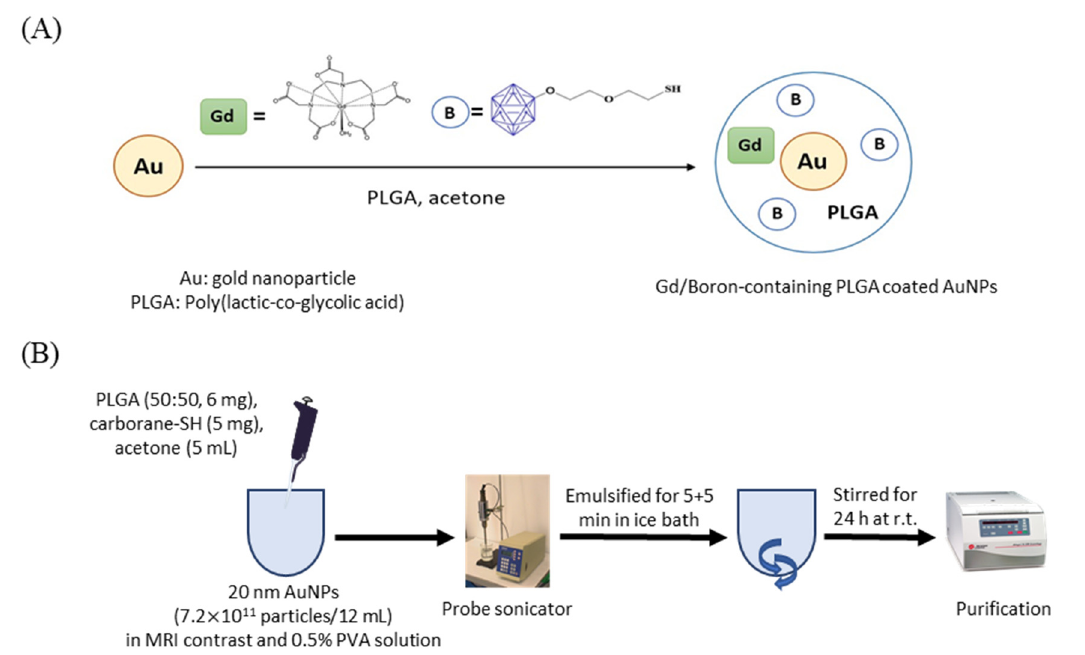
Figure 5. ( A ) Structure of self-synthesized thiol B cage (BC-EG-SH). ( B ) Synthetic scheme of PLGA nanoparticles.